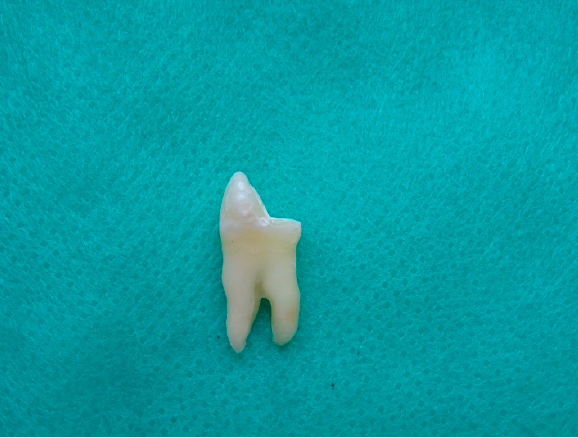
Figure 1. Premolar tooth with removed palatal tubercle.